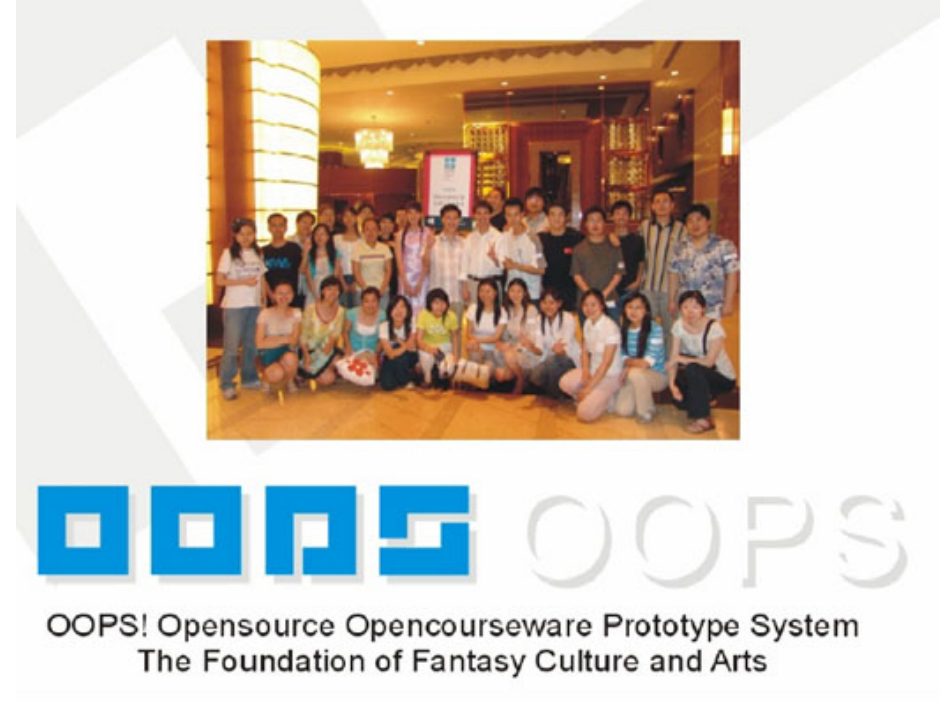
Figure 1. The Opensource Opencourseware Prototype System (OOPS)